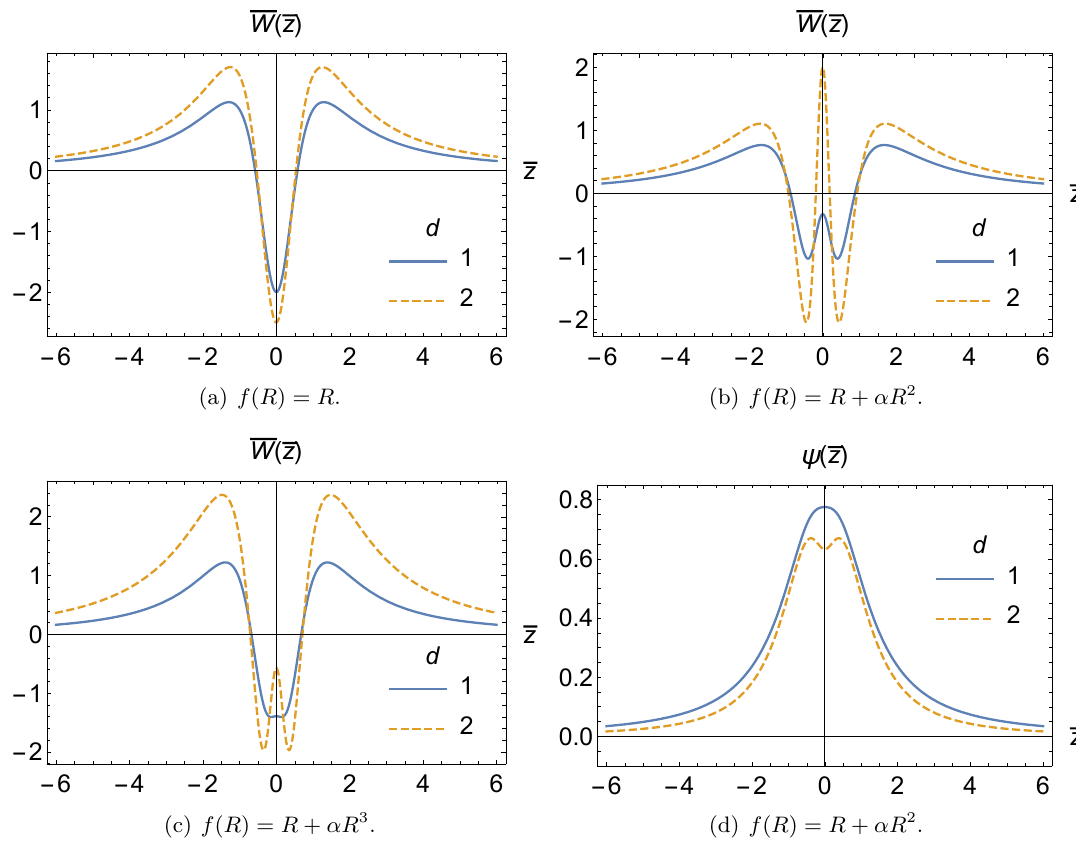
Figure 10 . Plots of the dimensionless effective potential ¯ W (¯ z ) in the Schrödinger-like equa- tion (3.14) for various f ( R ) models and the zero mode for f ( R ) = R + αR 2 , where ¯ z = kz and ¯ W (¯ z ) = W (¯ z ) /k 2 . In figures 10(b) and 10(d), we adopt ¯ α = k 2 α = − 1 / 20 . In figure 10(c), we adopt ¯ α = k 4 α = − 0 . 0025 . All the effective potentials approach to zero at ¯ z → ±∞